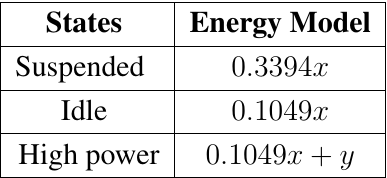
Table 3. The energy consumption of different states in joules with respect to the elapsed time in seconds. Term x represents the elapsed time, and y depicts the energy utilization on the smart phone side when performing the emergency navigation system.